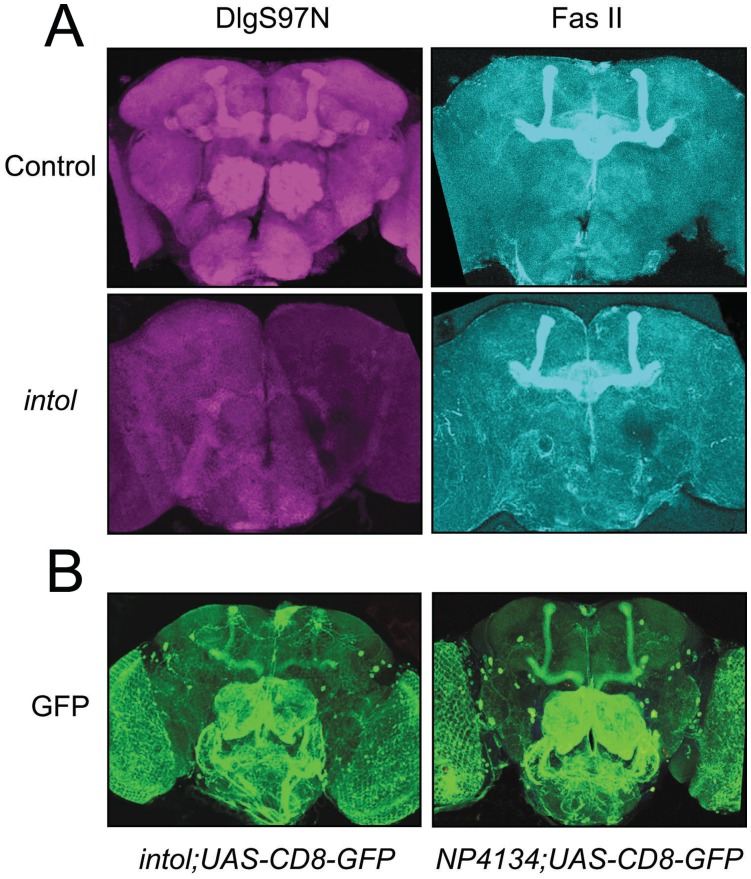
The intol mutant shows loss of DlgS97.(A) Whole-mount brains of Control (upper panels) and dlg1intol (lower panels) adult flies stained with anti-DlgS97 antibody (left panels, red) and anti-FASII antibody (right panels, blue). (B) Whole-mount brains of adult flies expressing UAS-CD8-GFP driven by dlg4134GAL4 or dlg16–99GAL4 and stained with anti-GFP antibody. Each image represents a stack of 20–25 optical sections taken at 0.5 µm steps.